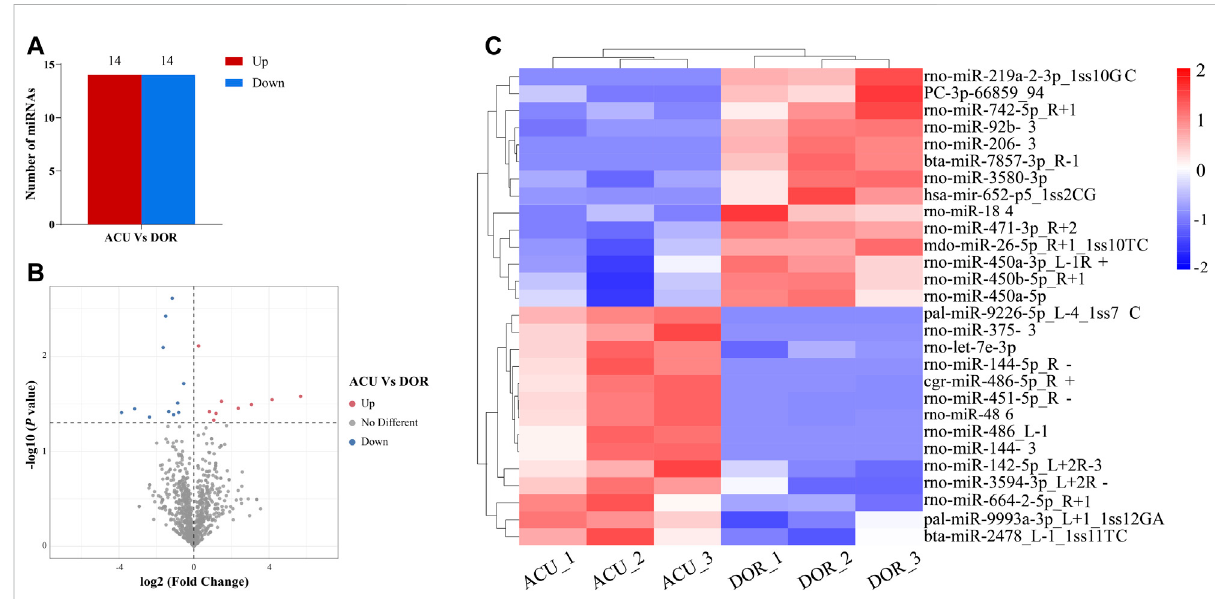
Acupuncture alters miRNA expression in DOR rats. (A) The number of upregulated and downregulated DE miRNAs was identi fi ed ( p < 0.01). (B) Volcano plot showing DE miRNAs ( p < 0.01). (C) Heatmap showing the relative expression of DE miRNAs ( p < 0.05, log2 (FC) ≥ 1 or < = − 1; red: high expression; blue: low expression). ACU, acupuncture group; CON, control group; DOR, diminished ovarian reserve; DE miRNAs, differentially expressed